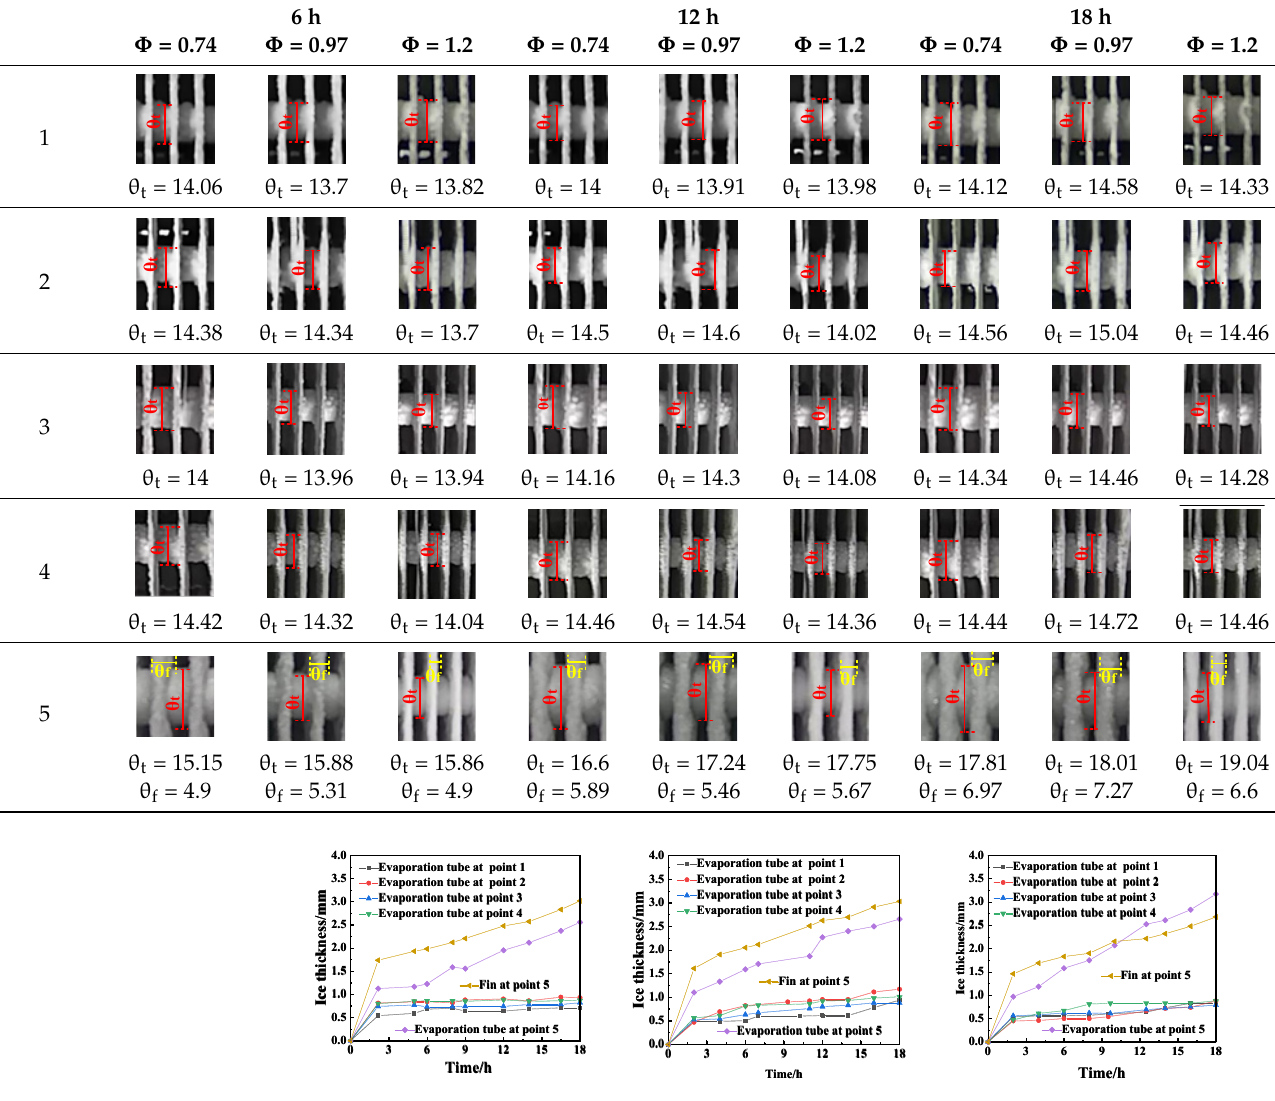
Table 4. Comparison of frost formation at 5 measuring points under different plenum-chamber coefficients, where θ t is the frosting thickness of the evaporator tubes (mm) and θ f is the frosting thickness of the fins (mm). 6 h 12 h 18 h 6 h Φ = 0.74 Φ = 0.97 Φ = 1.2 Φ = 0.74 Φ = 0.97 Φ = 1.2 Φ = 0.74 Φ = 0.97 Φ = 1.2